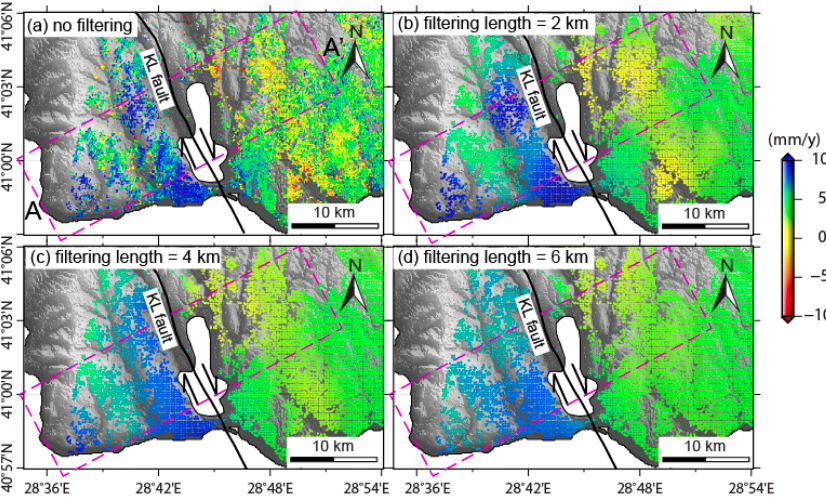
Figure 6. Horizontal velocity field along N30°W near KL: ( a ) Without spatial filtering; ( b – d ) Filtered data with different spatial filtering length. Purple boxes show the location of the velocity profile (A–A’) shown in Figure 7.